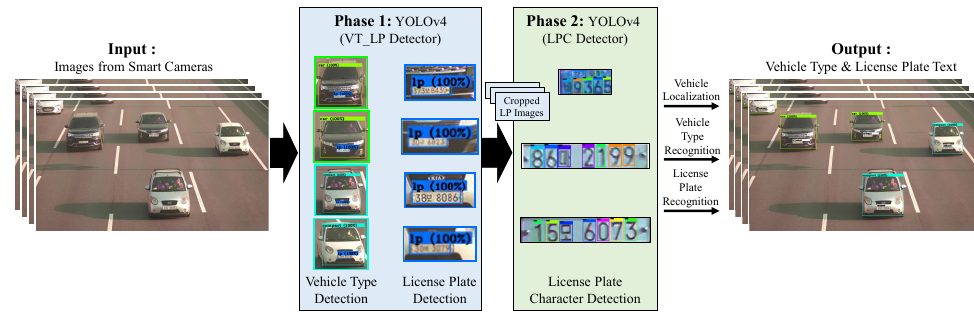
Figure 2. The overview of the KVT-LPR system.